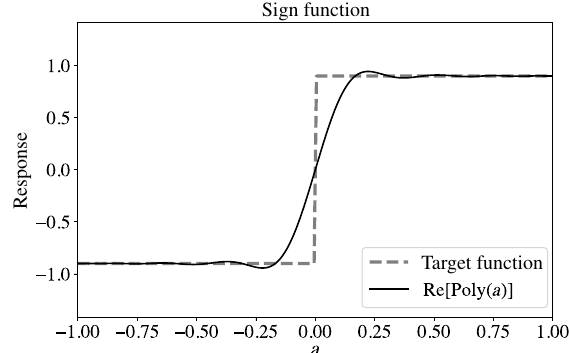
FIG. 21. The response function for the polynomial approxima- tion to the sign function with d = 19 and k =